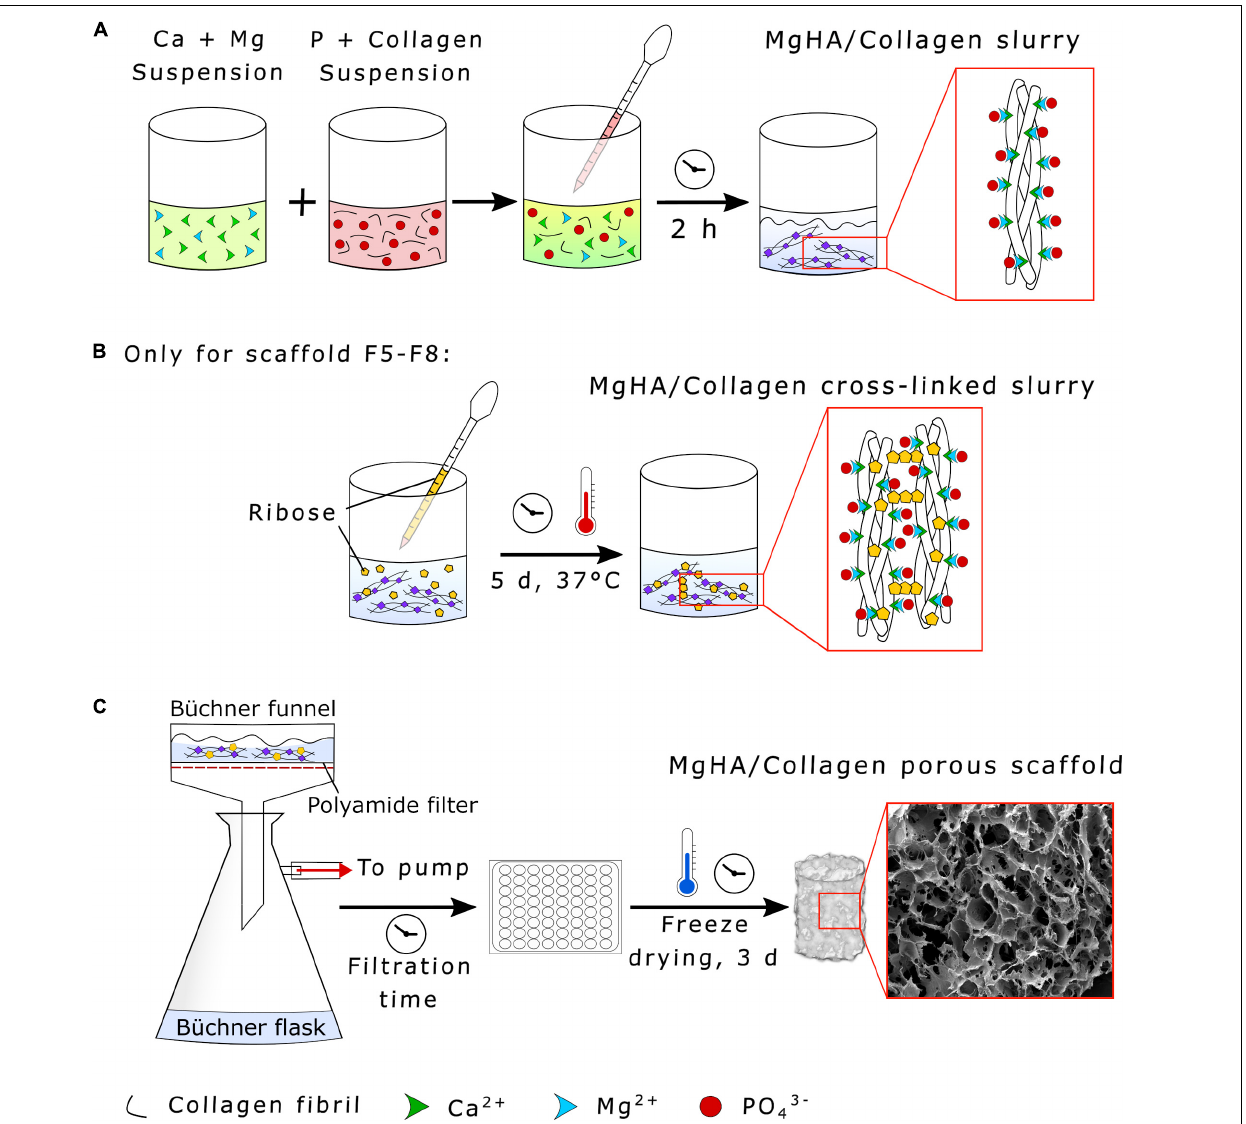
FIGURE 2 | Synthesis of HA/Collagen scaffolds. (A) Collagen biomineralization through neutralization process, (B) MgHA/Collagen slurry glycation with ribose (only for the scaffolds formulations F5–F8), and (C) vacuum filtration and scaffold